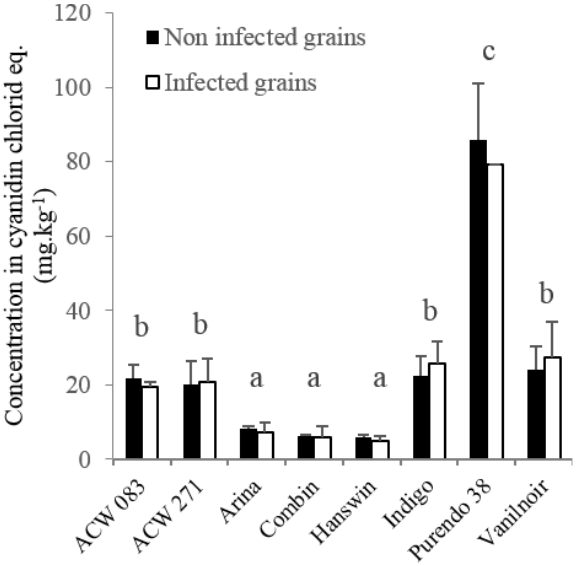
Figure 4. Mean anthocyanin concentrations (as cyanidin chlorid equivalent) in infected and in non-infected wheat grains from seven different wheat varieties. The values were calculated across three different field sites (environ - ments). Bars accompanied by the same letter are not statis- tically different ( P <0.05).